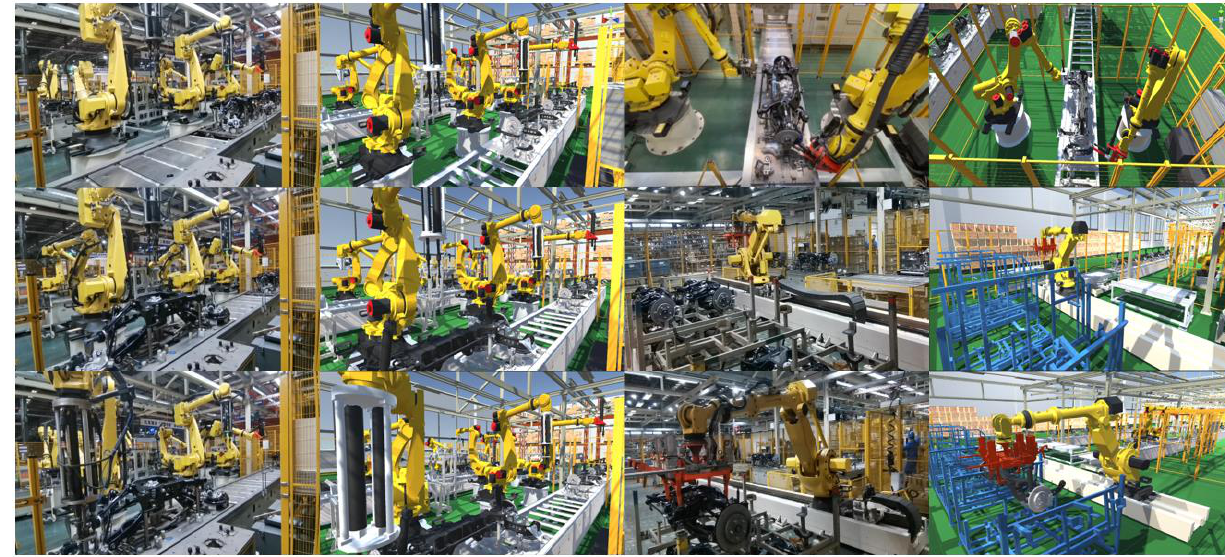
Figure 5. The real-time synchronization scenario of a digital twin. Table 1. Product line fault diagnosis sample